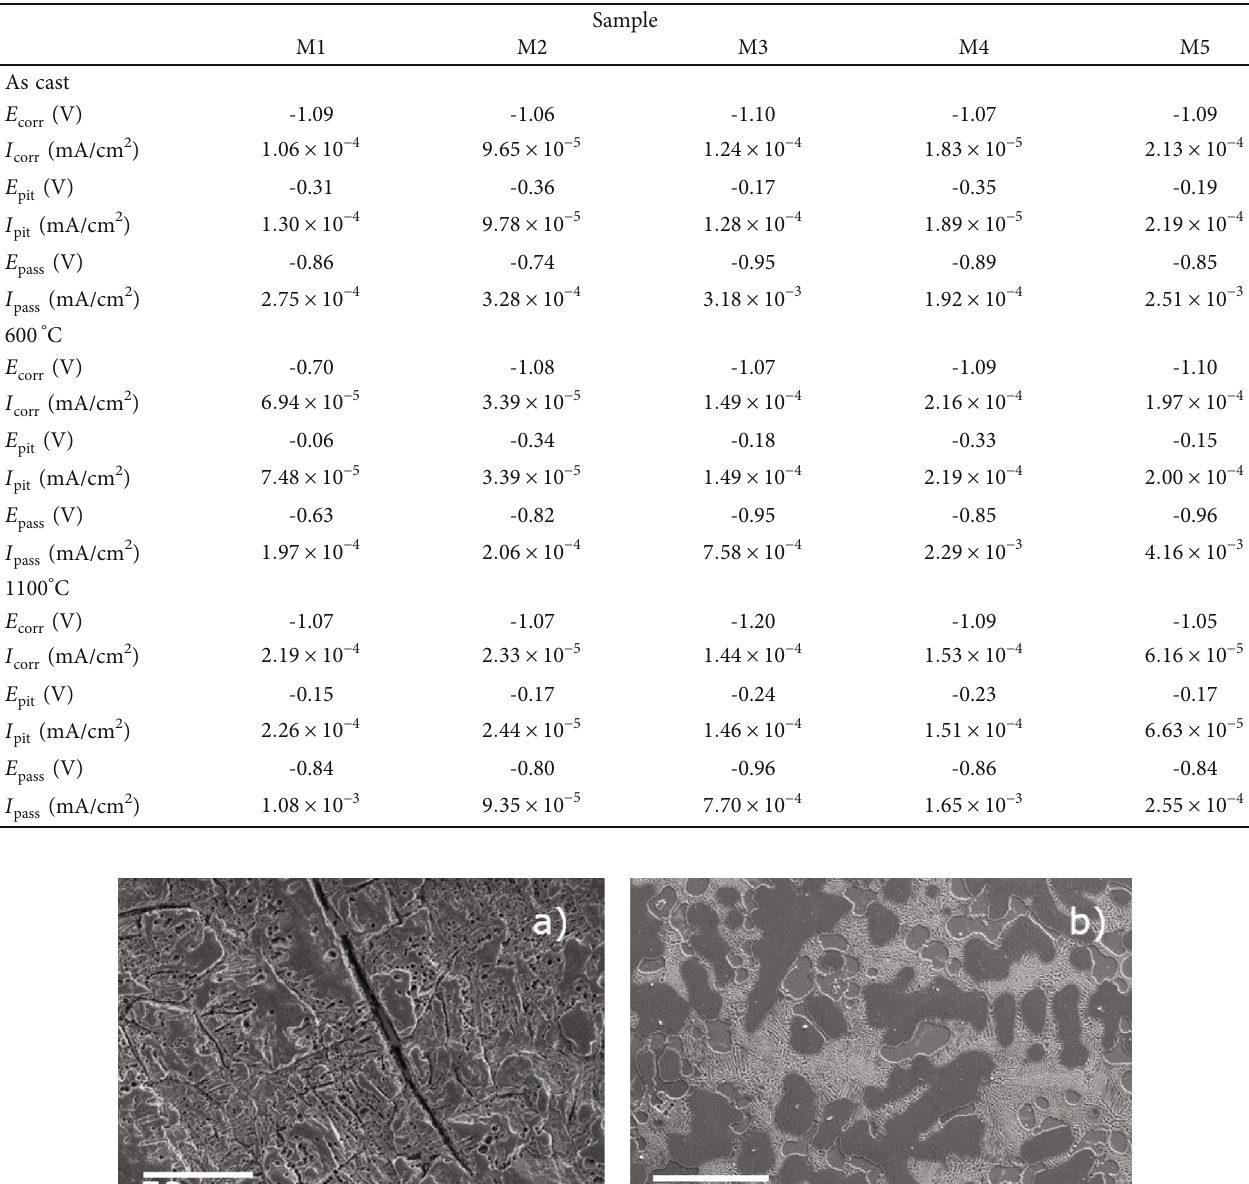
Table 5: Parameters obtained from polarization curves for aluminum-based alloy doped with Mn and Co as cast and after heat treatments at 600 and 1100 ° C.